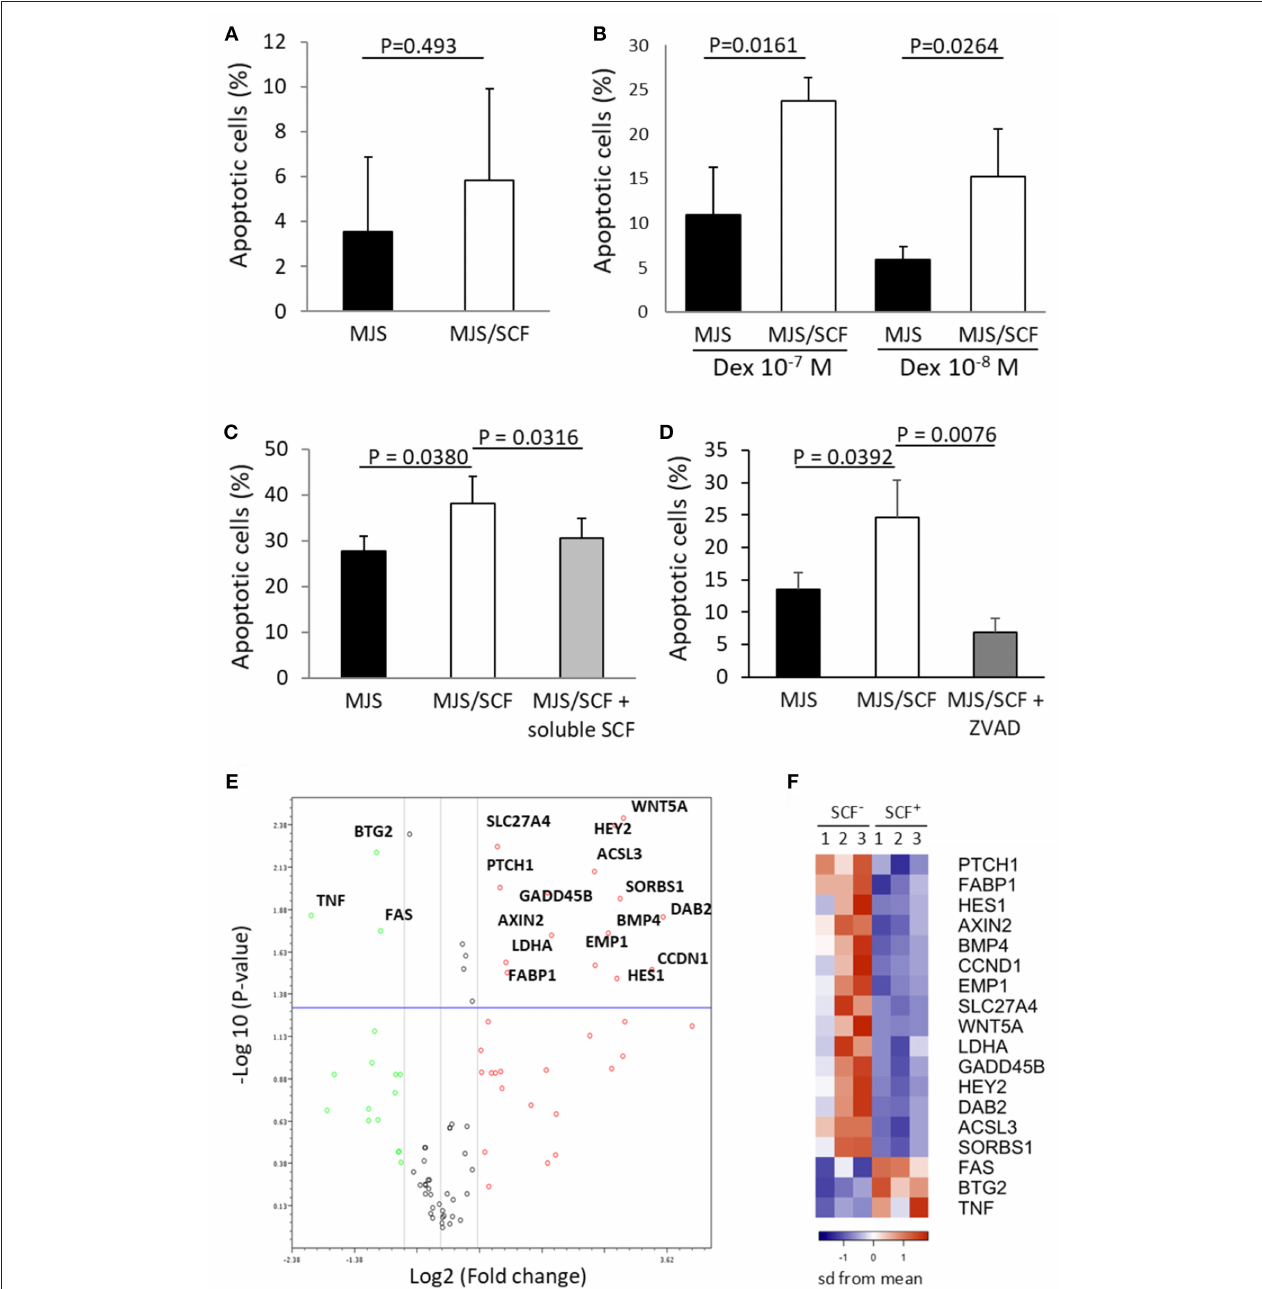
FIGURE 6 | Triggering of CD117 delivers a pro-apoptotic signal through regulation of specific genes. (A) Activation-induced and enriched CD117 + cells were co-incubated with SCF 220 -transduced or mock-transduced MJS cells and apoptosis after 24h was assessed by measuring hypodiploid DNA content. Data are from three independent samples. (B) Activation-induced and enriched CD117 + cells were co-incubated with SCF 220 -transduced or mock-transduced MJS cells in presence of dexamethasone for 24h prior to assessment of apoptosis. Data are from three independent samples. (C) Activation-induced and enriched CD117 + cells were co-incubated with SCF 220 -transduced or mock-transduced MJS cells in presence of galectin-1 (10 − 5 M). Apoptosis was measured after 24h. A subpopulation of CD117 + cells was pre-incubated with soluble SCF prior to co-incubation. Data are from three independent samples. (D) Activation-induced and enriched CD117 + cells were co-incubated with SCF 220 -transduced or mock-transduced MJS cells in presence of dexamethasone (10 − 7 M) with or without Z-VAD-FMK (10 − 4 M). Data are from three independent samples. (E) Enriched CD117 + cells were incubated overnight with MJS cells, either transduced with SCF 220 or mock-transduced, in the presence of dexamethasone (10 − 7 M). MJS cells were then removed and expression of 84 genes representing canonical signaling pathways was determined. The plot shows genes that are upregulated (red) or downregulated (green) in CD117 + cells co-incubated with SCF 220 -transduced MJS cells. Data are from three independent samples. (F) Heat map showing the major differentially-expressed genes in CD117 + cells co-incubated with MJS cells transduced with SCF 220 (SCF + ) compared to mock-transduced cells (SCF − ). The down-regulated genes in blue and up-regulated genes in orange.